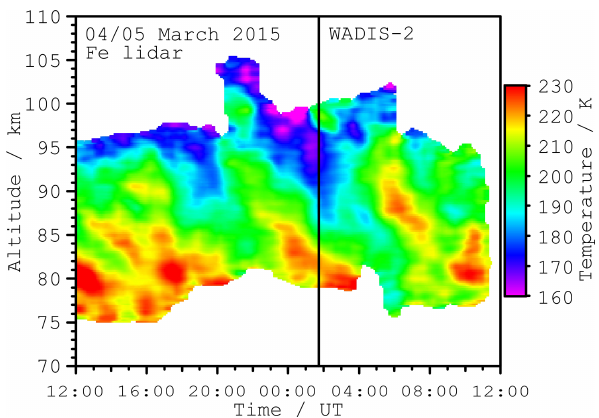
Figure 3. Temperatures measured with the Fe lidar in the 24h pe- riod around the WADIS-2 launch at 01:44UT (vertical line). Mea- surement uncertainties are smaller than 10K throughout the altitude range and decrease to around 2K towards altitudes with the highest Fe density.